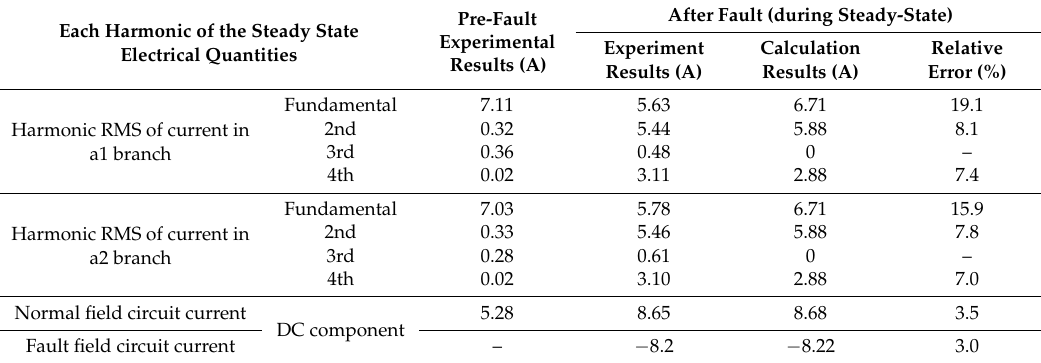
Table 2. Different harmonics root mean square (RMS) of steady state current under inter-turn circuit of taps 2–4 under load condition connected to power grid.